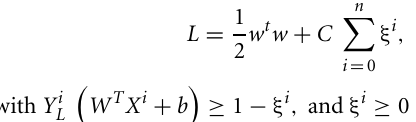
Frontiers in Neuroscience |